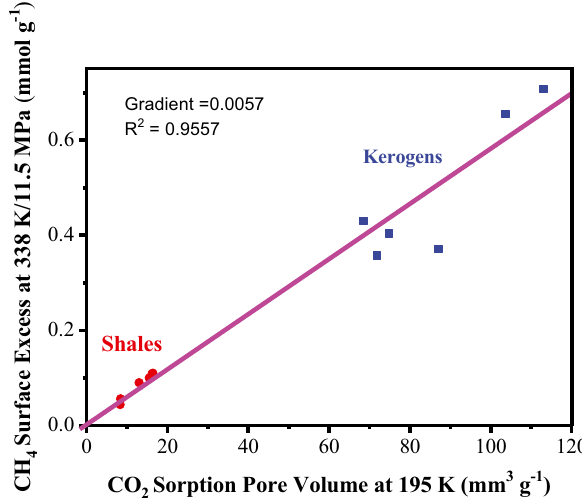
Fig. 9 The variation of high pressure supercritical CH excess adsorption at 11.5 MPa and 338 K for Posidonia shales and kerogens with subcritical CO